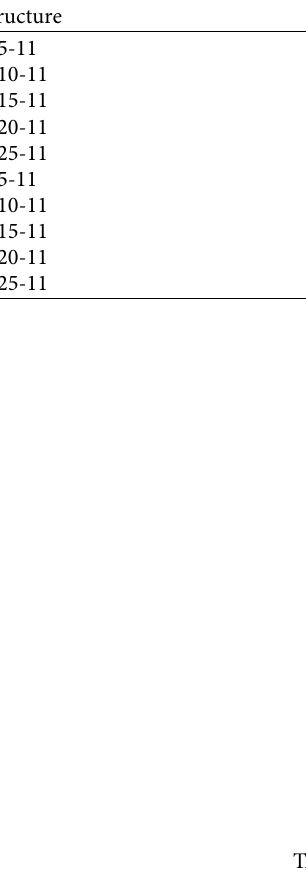
Table 3: Comparison of ANN structure.